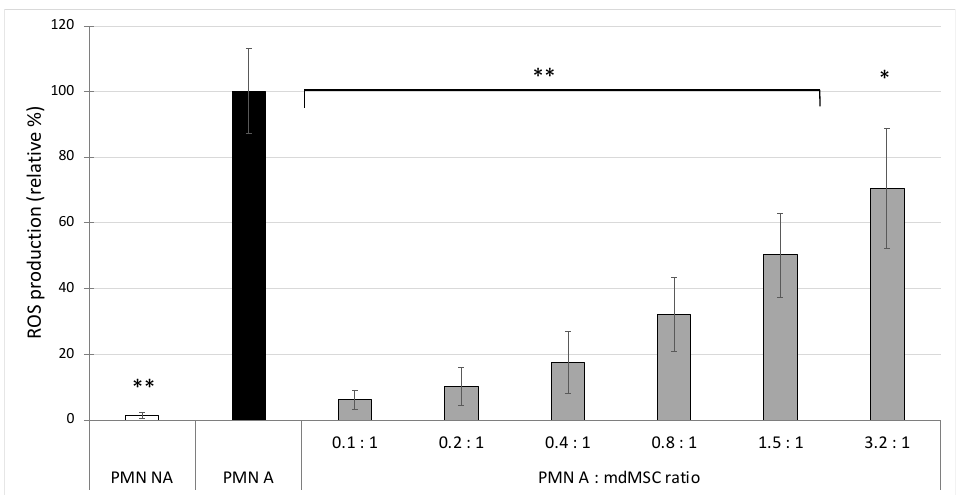
Figure 1. Effect of non-activated (PMN NA) and PMA-activated neutrophils (PMN A) alone or mixed with mdMSCs at different ratios (PMN A: mdMSC ratio) in DPBS on ROS production. Results from five independent experiments ( n = 5) with 2 technical replicates for each point, including 4 horses for the mdMSCs and 5 horses for the neutrophils. Means ± SD are shown in relative percentages versus stimulated neutrophils without mdMSCs (PMN A), defined as 100% response. Statistical analysis was considered for 5 independent experiments ** p < 0.01, * p < 0.05 versus PMN A.